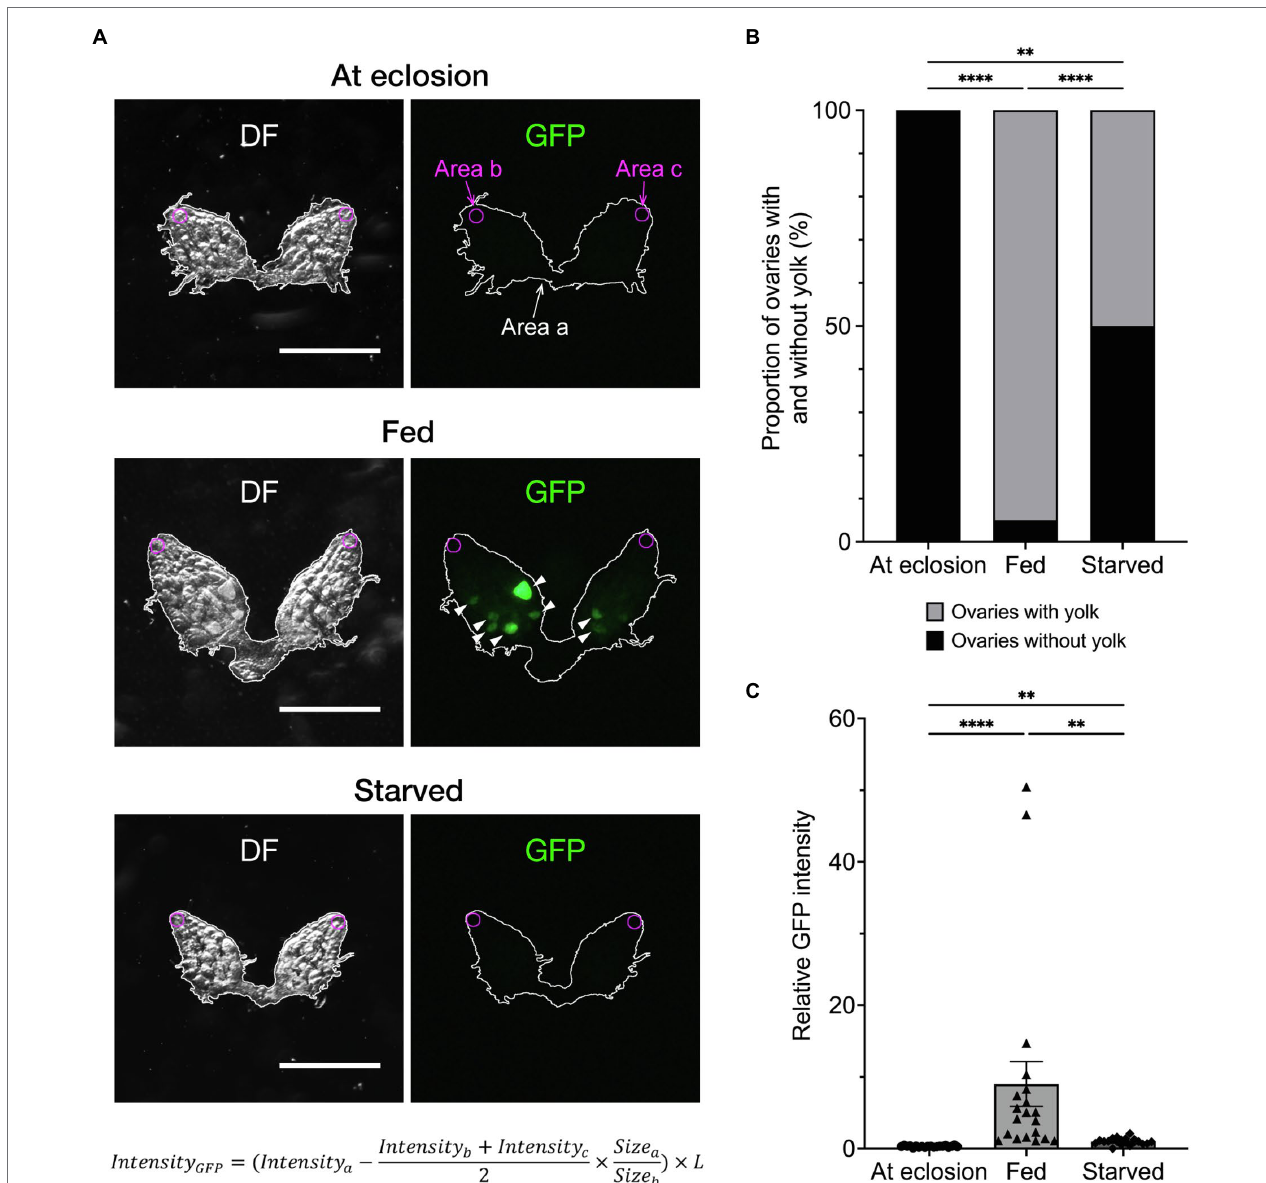
FIGURE 2 | Effects of feeding on yolk accumulation in the ovary. (A) Representative images showing GFP fluorescence in the ovaries of an unfed fly at emergence (top), 7-day-old fly fed on normal food (middle) and 7-day-old starved fly (bottom). Each ovary is observed under dark field (DF; left) and fluorescence illumination (GFP; right). Yp1::GFP -derived fluorescence signals are indicated by arrowheads. Fluorescence intensities are measured at three different regions in the ovary; i.e. Area a (inside the white line that delineate the outer limit of the ovary, wherein the yolk is measured); Area b and Area c (regions in germaria located at the anterior tip of the left and right ovarioles, respectively: circled with magenta lines). The circles are of 68.9 μ m in diameter (equivalent to 30 pixels) and positioned manually so that it is inscribed at the contact point of the terminal filament and an ovariole that is located at the centre of an ovary. Germaria are occupied by germ stem cells and proliferating daughter cells that are devoid of yolk. Thus, the mean fluorescence intensity measured within germaria (Intensity b + Intensity c )/2, represents background noise, which is subtracted from the Yp1::GFP -derived fluorescence measured in Area a and Intensity a . The subtracted value is normalised for the sizes of measured areas (Size a /Size b ) and, when necessary, also for the body size differences (described by the factor L ), resulting in Intensity GFP . The factor L is defined as the body length (the distance between the head tip and the end of the abdominal segment) of a test fly relative to the mean body length of all flies from the relevant control group. Scale bar: 500 μ m. (B) The proportion of flies in the non-dormancy state (flies carrying at least one yolked oocyte) and dormancy state (flies with unyolked oocytes only) as defined by the conventional method is compared between fed and starved flies. Animals are raised on normal food (see Methods for compositions) at 25 ° C throughout the larval stage, then divided into three groups at eclosion: the first group is fed normal food (fed flies); the second group is contained in an agar- only medium at 11 ° C for a week (starved flies); and the third group is sacrificed immediately after eclosion to observe the ovaries. The genotype of flies: Yp1::GFP/+ . n = 20–40. (C) The fluorescence intensity values (in a.u.) are compared among the three feeding states. The photoperiod applied was L/D: 12/12 throughout the experiments. The mean ± SEM are indicated. n = 20. Statistical significance was evaluated by the Fisher’s exact test (B) and the Kruskal–Wallis test with post-hoc test (C) : ** p < 0.01 and **** p <